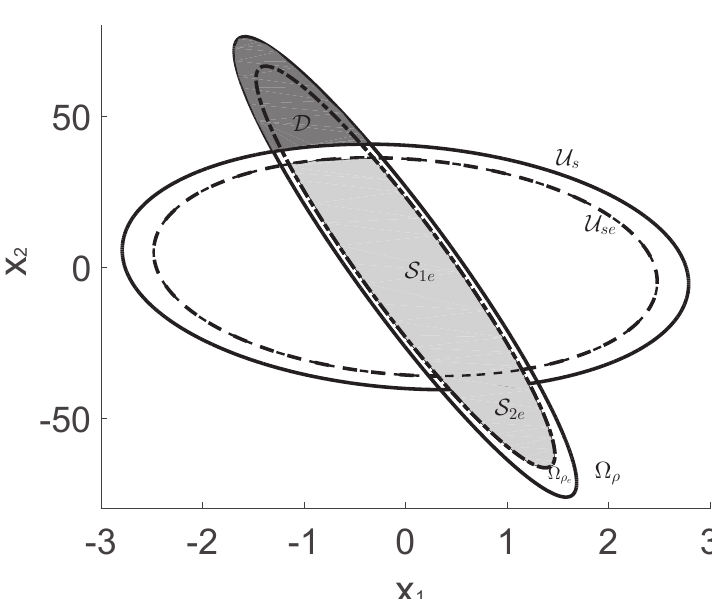
Figure 3. A schematic representing the unsafe region D (dark gray) and the region S e : = S 1 e ∪ S 2 e (light gray), which is the safe operating region S subtracting the risk margins ρ − ρ e and s − s e